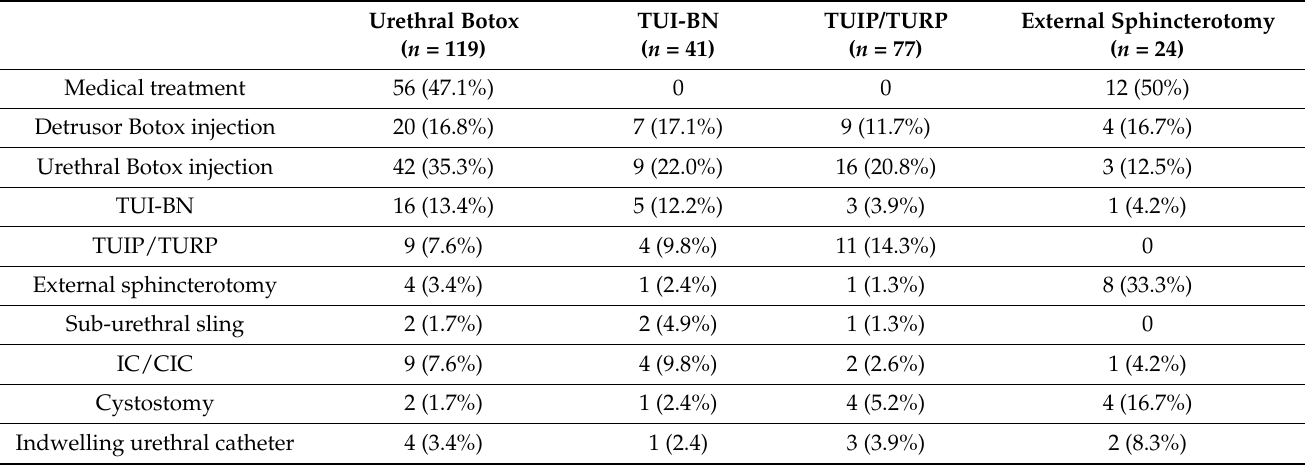
Table 6. Changes of bladder management or surgical procedures after initial treatment for voiding dysfunction in chronic spinal cord injury